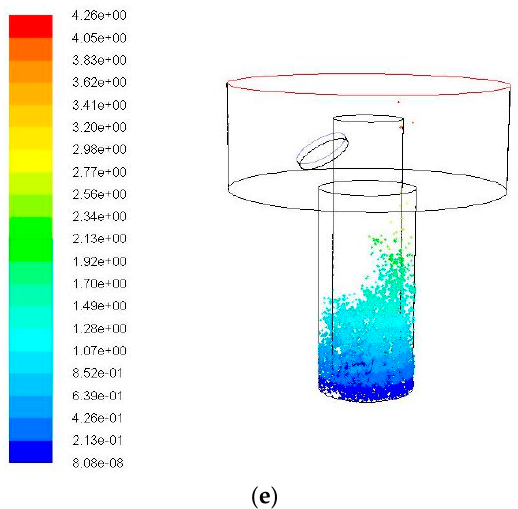
Figure 10. The debris movement with time when ultrasonic frequency is 40 kHz, amplitude is 5 μ m.